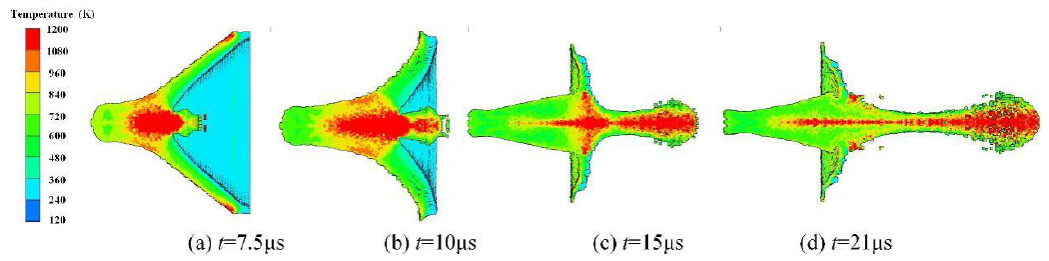
Figure 6. Typical temperature changes during reactive composite jet formation. The temperature time–history curves of the particles at the axis of the reactive liner are shown in Figure 7. The charge detonates at t = 0 µ s. Subsequently, the reactive liner heats up under the action of the detonation wave, forming a temperature peak, and the inner wall of the liner is crushed and closed at the axis. The temperature of the inner wall continues to rise under crushing collision, and the entire temperature rise process lasts approximately 5 µ s. The temperature of the inner wall reaches the highest peak at 7.5 µ s after detonation of approximately 1450 K, and then the particle temperature at the top axis of the liner begins to gradually decrease and stabilize.